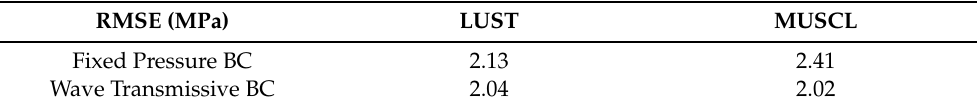
Figure 9. Top : Pressure profiles along the near wall of the nozzle with experimental data presented for comparison, Embedded: Close up of profiles reaching saturation pressure. Bottom : Vapour fraction profiles along the near wall of the nozzle. Table 5. Root Mean Square Error against experimental data near the wall of the nozzle for injection pressure of 7